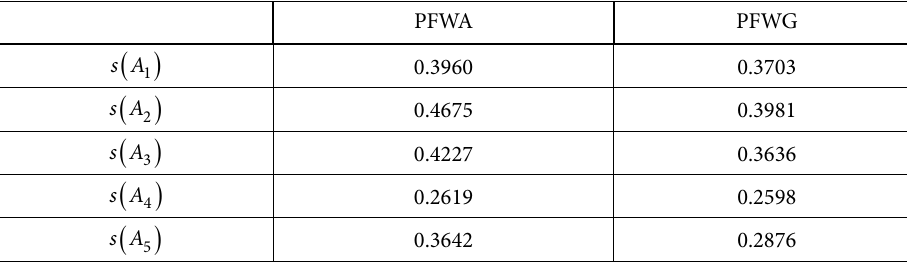
Table 9. Score results of five alternatives